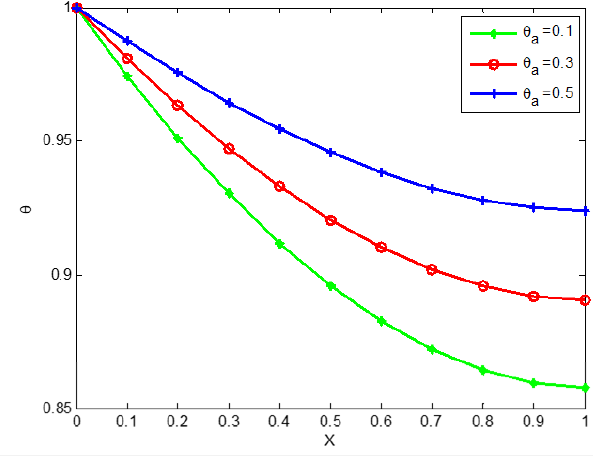
Figure 16. Non-dimensional Temperature in concave Aluminium porous fin different ambient temperature